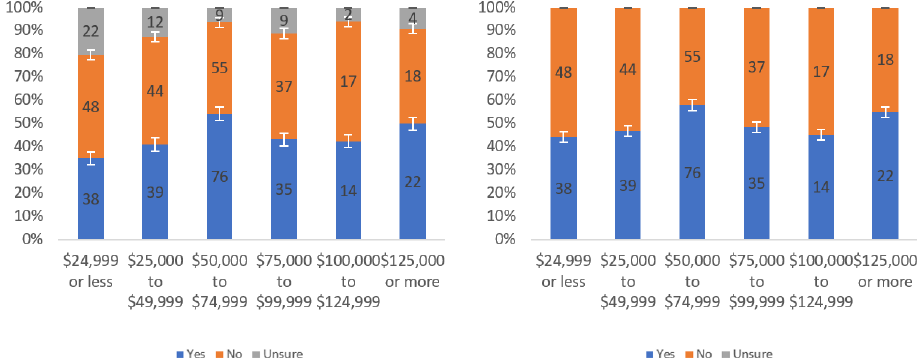
Figure A34. Responses regarding label annoyingness by income level including ( left ) and excluding ( right ) unsure responses.